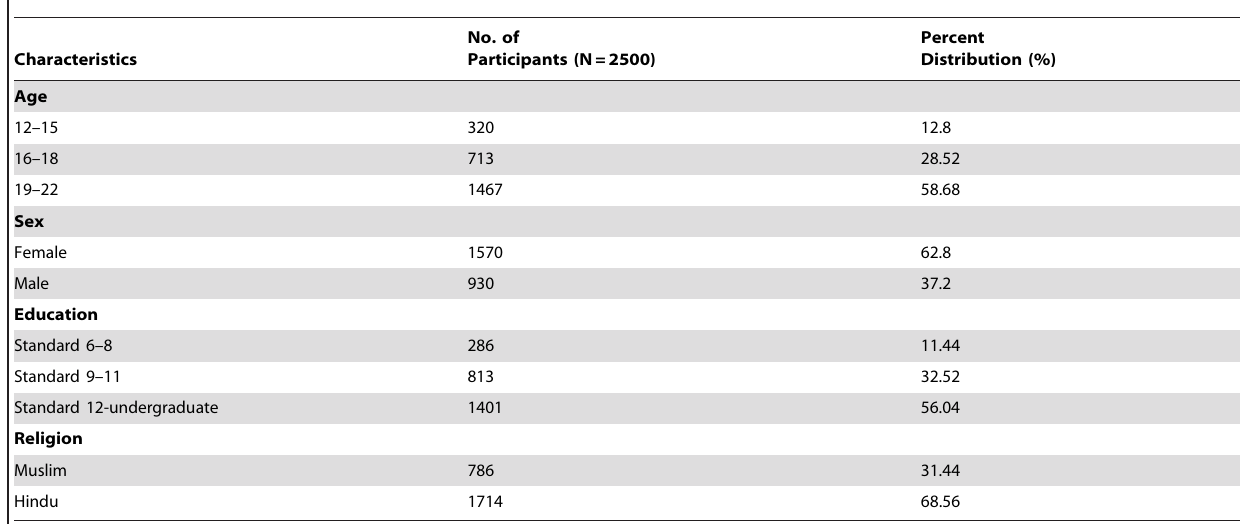
Table 1. Demographic characteristics of the population studied.